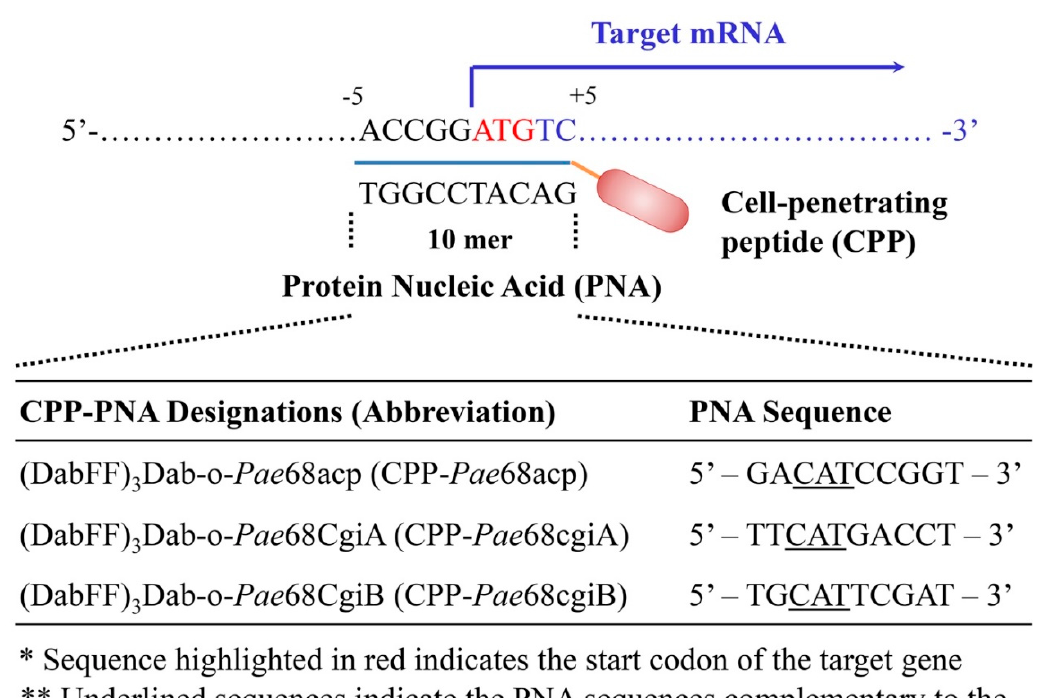
Figure 1. RNA translation inhibition with CPP-PNA and the CPP-PNA probes used in this work. Dab and F each represents the amino acid residues 2,4-diaminobutyric acid and phenylalanine that make up the CPP. 2-aminoethoxy-2-ethoxy acetic acid (AEEA) represented here as the -o- linker is used to link CPP with PNA. All probes were designed and synthesized